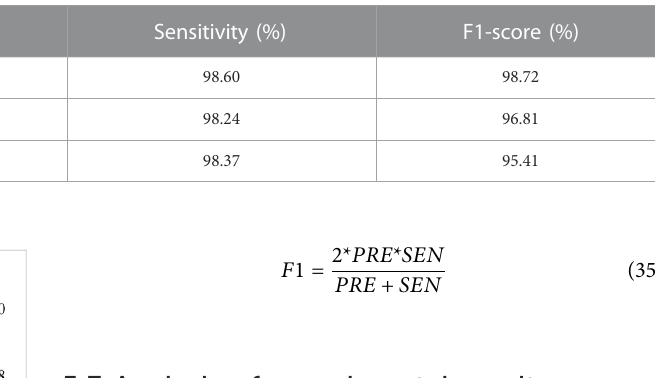
TABLE 5 Precision, sensitivity and F1-Score of different models.